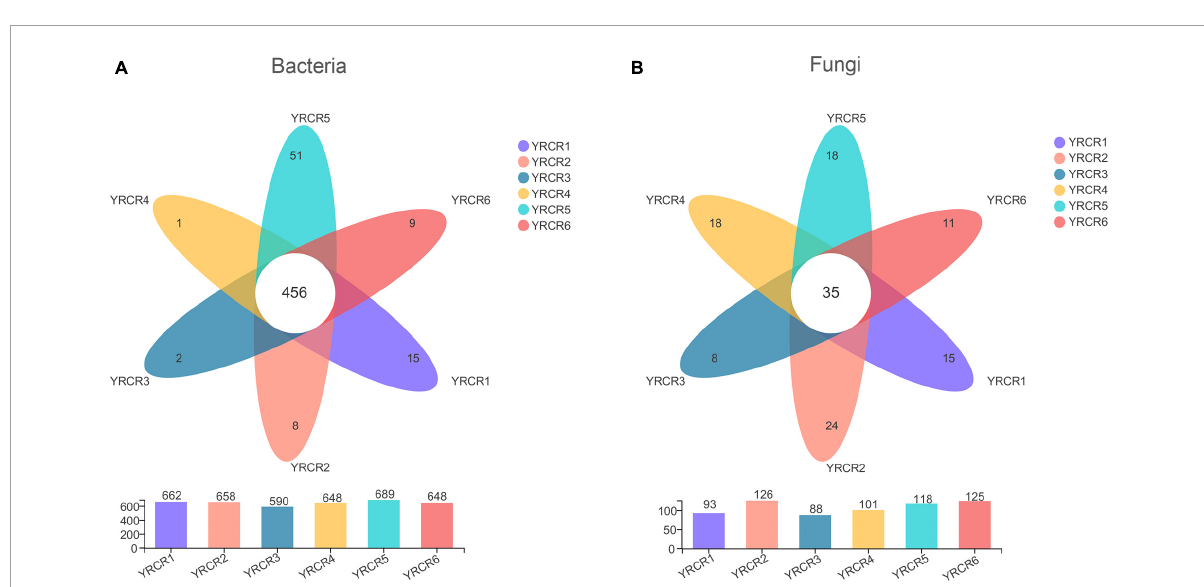
FIGURE2 Venn diagram at the genus level of six samples. (A) Represents bacteria, (B) represents gungal. Each circle with different colors in the diagram represents a group; middle core numbers represent the number of genus common to all groups.